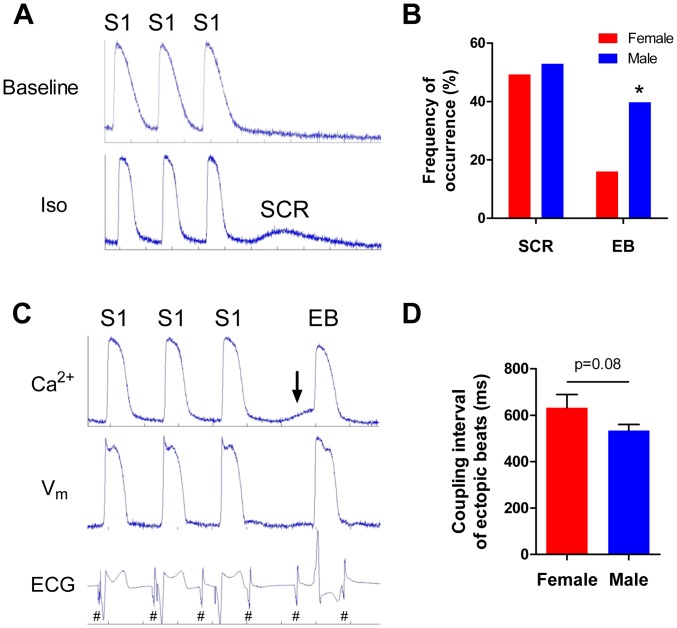
Iso-induced SCR and ectopic activity.A) Representative CaTs from a male heart during the last three paced beats (S1) of a 3 Hz drive train. Top, at baseline calcium levels return to diastole. During treatment with Iso (31.6 nM), an SCR occurs shortly after the return to diastolic calcium levels. B) Sex differences in the frequency of pacing protocols that elicited SCRs and EBs during treatment with Iso. C) Simultaneous recordings of Ca2+, Vm, and the volume-conducted ECG from a male heart showing the last three paced beats (S1) followed by an SCR (arrow) and an EB elicited by treatment with 31.6 nM Iso. Note that the smaller, regularly occurring activations (#) in the ECG are derived from the intrinsic activity of the left atrium. This confirms the complete atrioventricular dissociation in CHB hearts. D) Sex difference in the coupling interval (ms) between the activation of the last paced beat and EBs elicited during treatment with Iso. *p<0.05, female vs male.